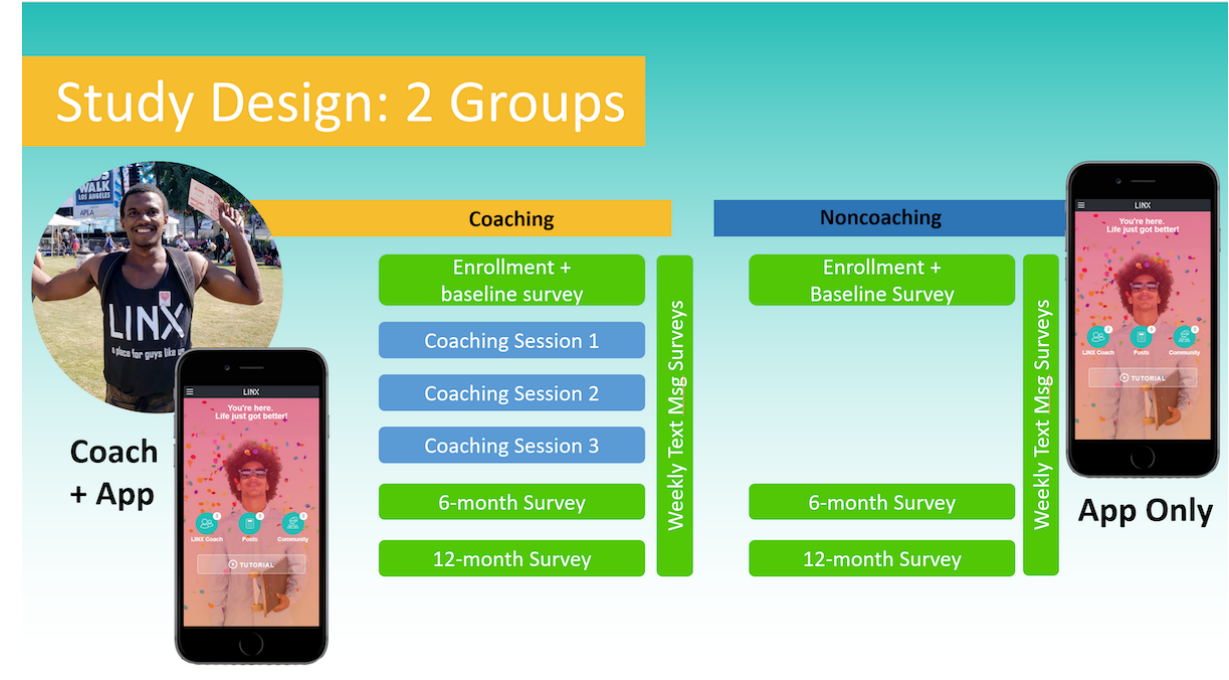
Figure 1. Study design of the LINX